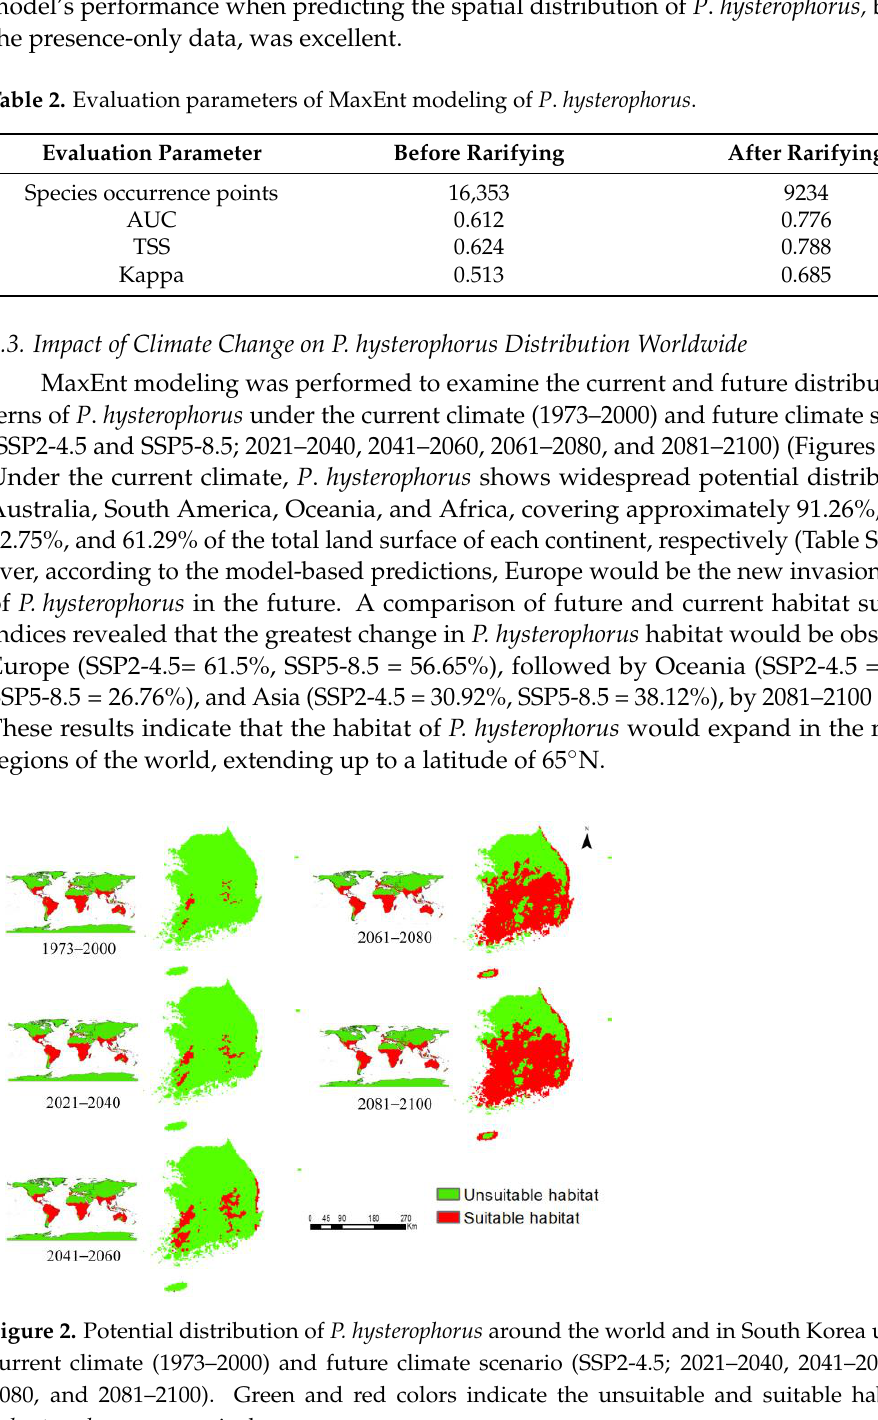
Figure 3. Potential distribution of P . hysterophorus around the world and in South Korea under the current climate (1973 – 2000) and future climate scenarios (SSP5-8.5; 2021 – 2040, 2041 – 2060, 2061 – 2080, and 2081 – 2100). Green and red colors indicate the unsuitable and suitable habitats for P. hys- terophorus , respectively.